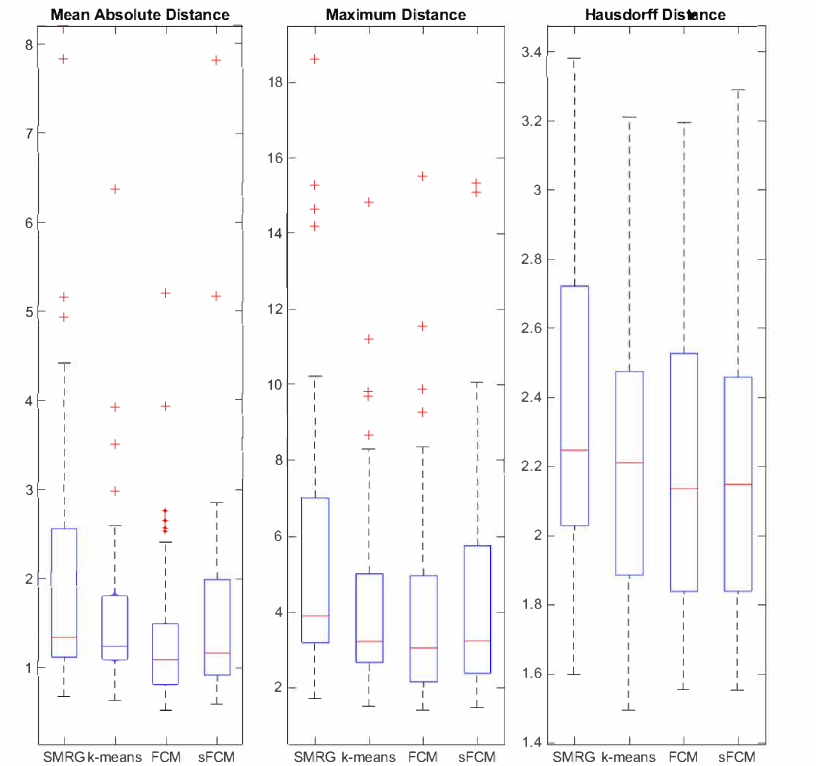
Figure 11. Boxplots of the spatial distance-based metrics achieved by the considered unsupervised segmentation approaches. From left to right: Mean Absolute Distance, Maximum Distance and Hausdorff Distance. The lower and upper bounds of each box represent the first and the third quartiles of the metric distribution, respectively. The median is represented by a red line, while outliers are displayed as red